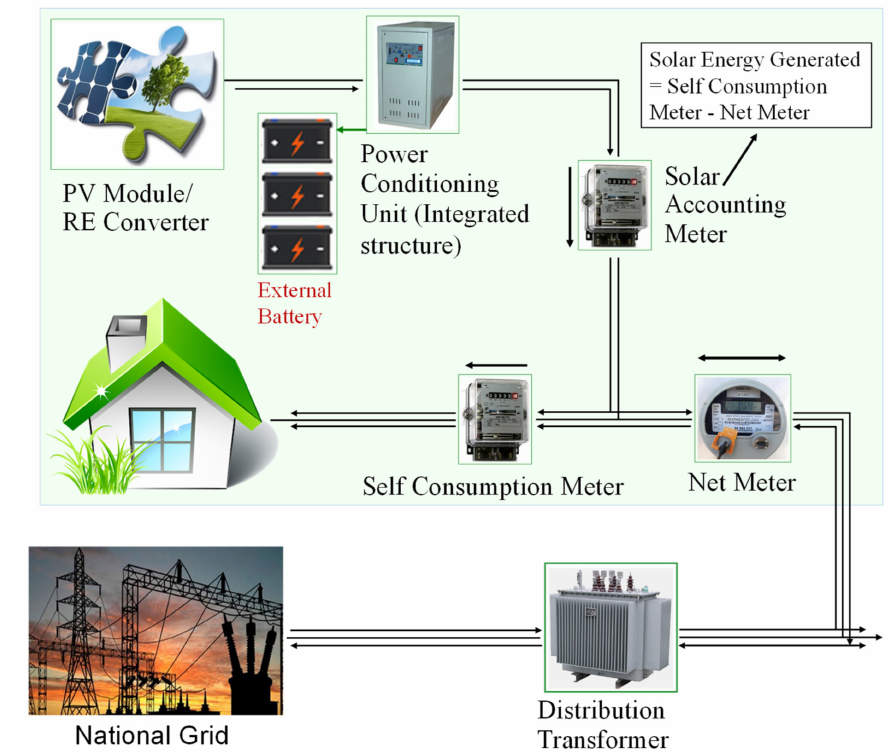
Figure 13. Typical net metering arrangement (authors’ creation based on ref. [75]).